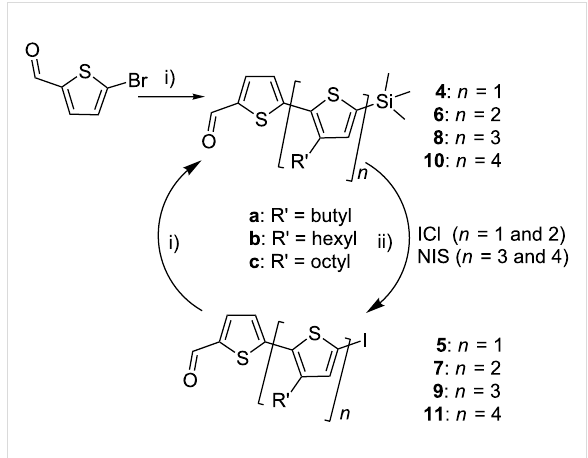
Scheme 2: Oligothiophenes 4 – 11 synthesised through reaction of the commercially available 5-bromo-2-thiophenecarboxaldehye with 3a–c